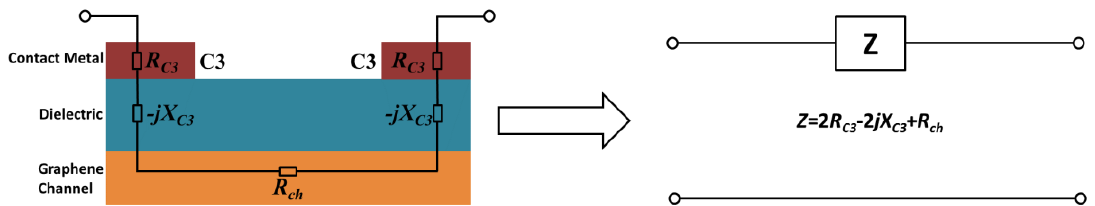
Figure 4. Schematic of a radio frequency (RF) transmission line method (TLM) structure on graphene, with a small-signal equivalent circuit overlaid on top, and the equivalent two-port network.